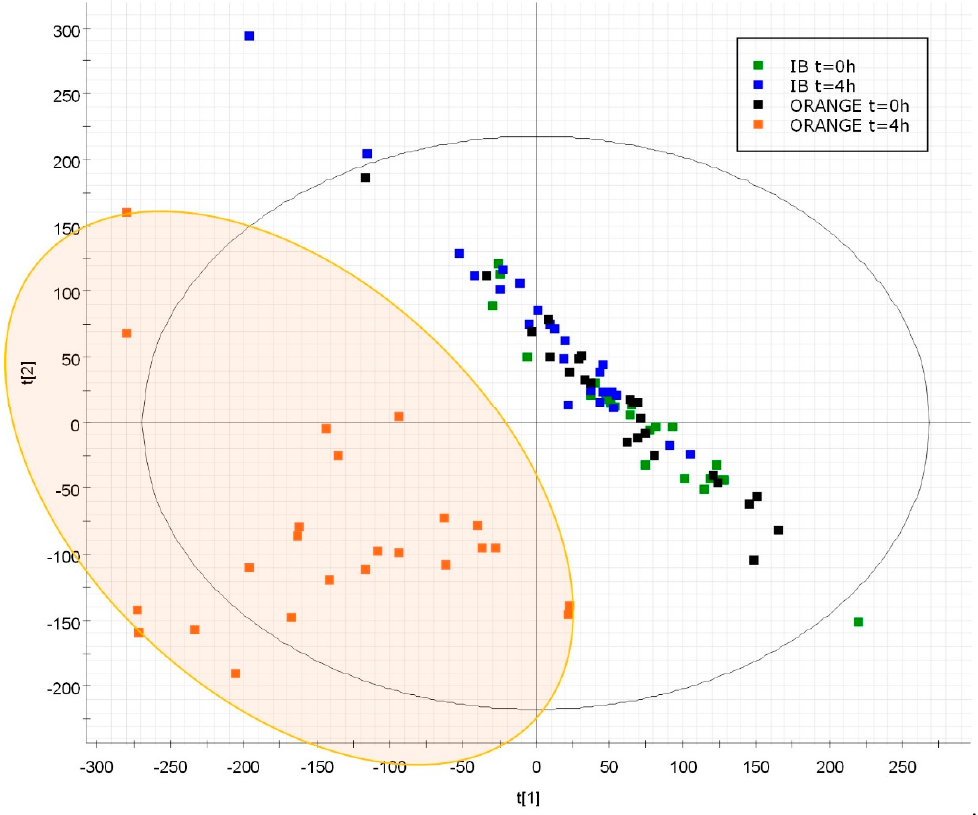
Figure 2. PLS-DA score plot based on the features with repeated measures ANOVA p -value ≤ 0.05. A 2D vision component 1 vs. component 2 with 24.5% and 13.8% of the variance explained, respectively. The samples obtained at t = 0 h and t = 4 h after the intake of an isocaloric beverage (IB) and the samples obtained at t = 0 h and t = 4 h after orange intake are colored in green, blue, black and orange, respectively.